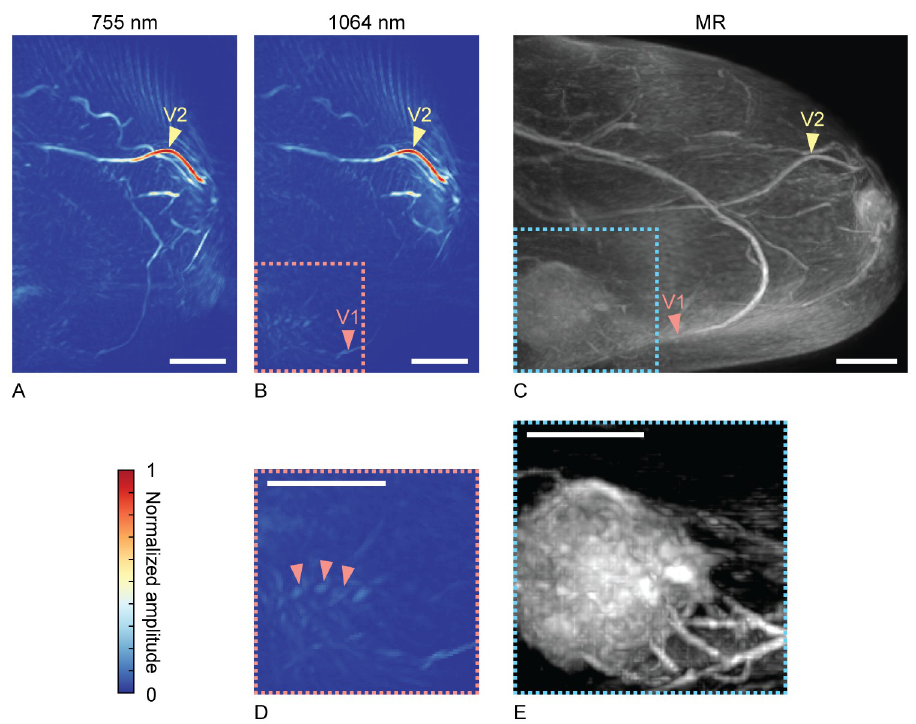
Fig 6. Case 2. Photoacoustic MIPs at 755 nm (A) and 1064 nm (B) in the sagittal plane. (C) Post-contrast dynamic T1 MR MIP in the sagittal plane. (D) Zoomed subsection of (B). (E) Zoomed subsection of the region marked in (C), where a MIP of a slab of tissue with thickness 50 mm is taken (containing the entire tumor); contrary to (C), where a projection of the entire breast is taken. All scale bars represent 20